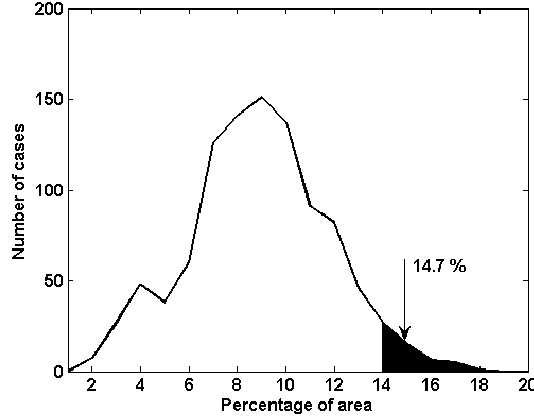
Fig. 12. Correlation of AIRS derived daily effective cloud fraction anomalies (for the NDJFM period; with respect to 2002–2011 cli- Fig. 12: Correlation of AIRS derived daily effective cloud fraction anomalies (for the matology) with the daily AO index. The contours show regions with NDJFM period; with respect to 2002-2011 climatology) with the daily AO index. The correlations observed at 95% confidence level. contours show regions with correlations observed at 95% confidence level.